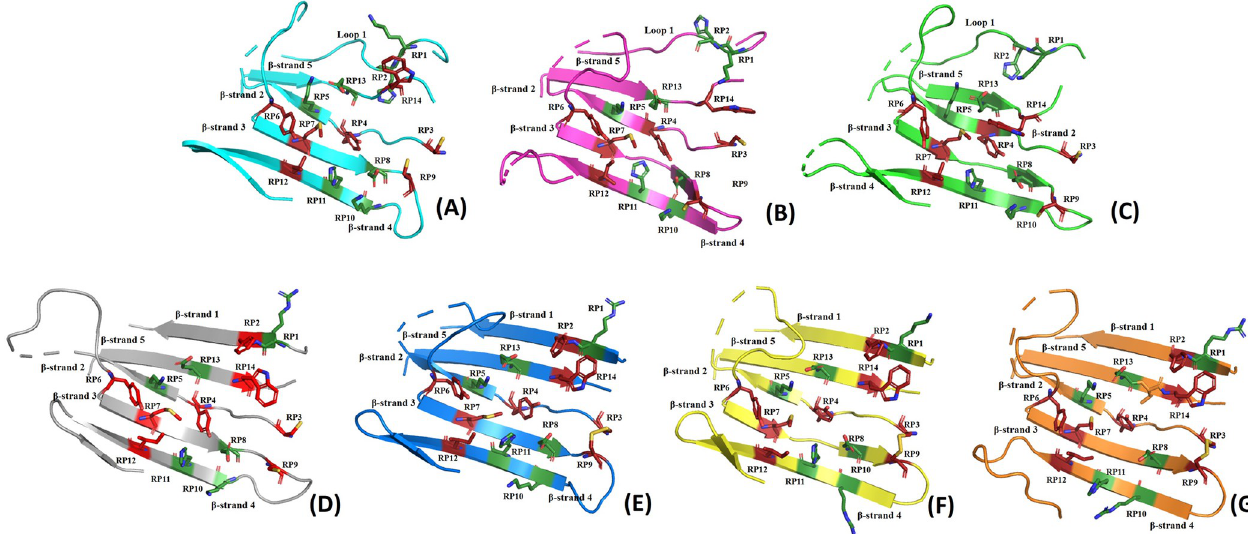
Fig 2. CRDs of the seven lectins showing the key conserved amino acid residues on the β strands. (A) Calnexin of Canis lupus (dog); (B) Calnexin of Humans; (C) Calmegin from Humans; (D) Calreticulin from Humans; (E) Calsperin from Humans; (F) Calreticulin from Entamoeba histolytica ; and (G) Calreticulin from Trypanosoma cruzi . Polar amino acids are shown in green and non-polar amino acids in red.